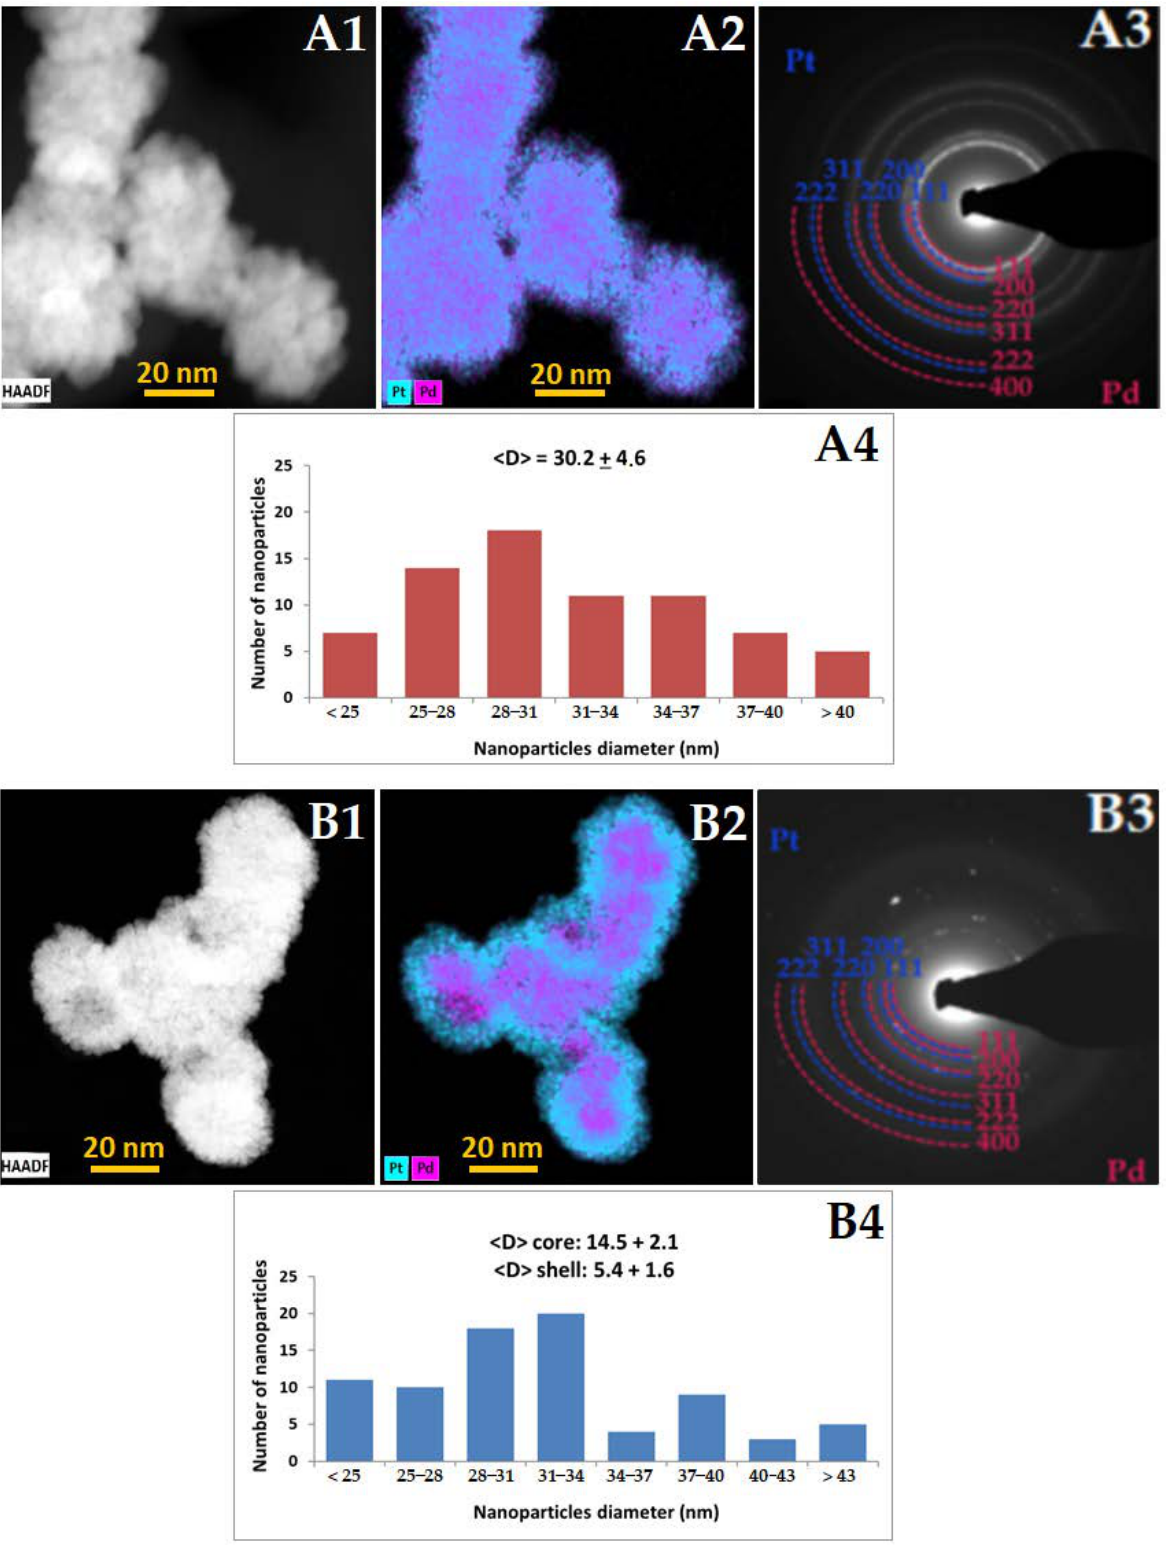
Figure 3. STEM HAADF images of ( A1 ) PdPt (I) and ( B1 ) PdPt (II) NPs with the corresponding ( A2 , B2 ) EDS distribution maps, ( A3 , B3 ) SAED patterns indexed with lattice parameters of palladium and platinum and ( A4 , B4 ) size distributions (diameter of NPs/core/shell ± standard